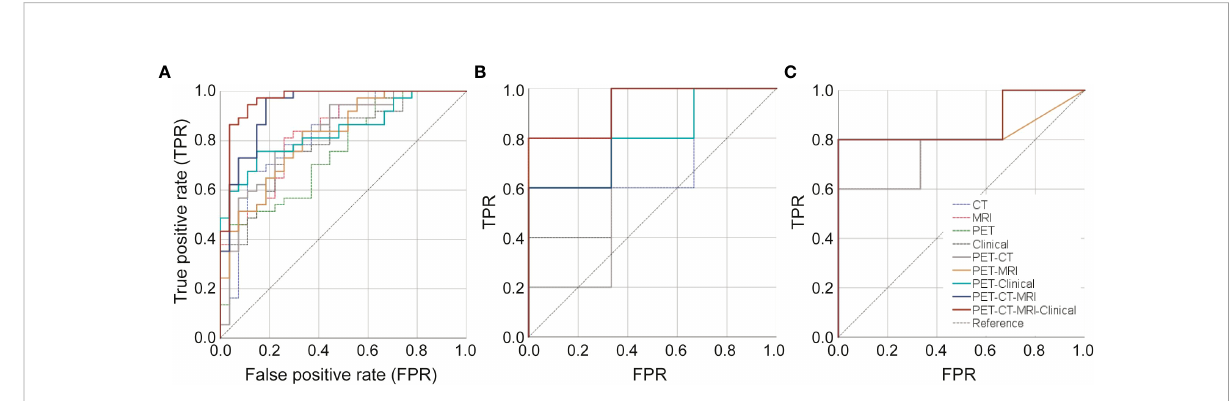
FIGURE 2 ROC curves of different prediction models. Nine ROC curves in the training set (A) , internal testing set (B) and external testing set (C) .